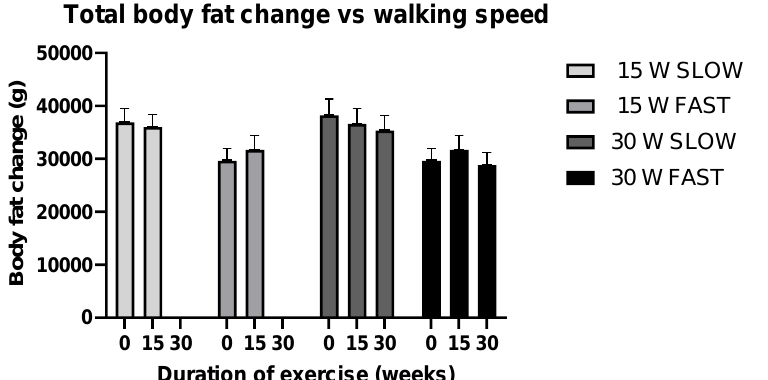
Figure 2. Effects of walking speed, measured by DXA on total body fat after 15 and 30 weeks of walking.